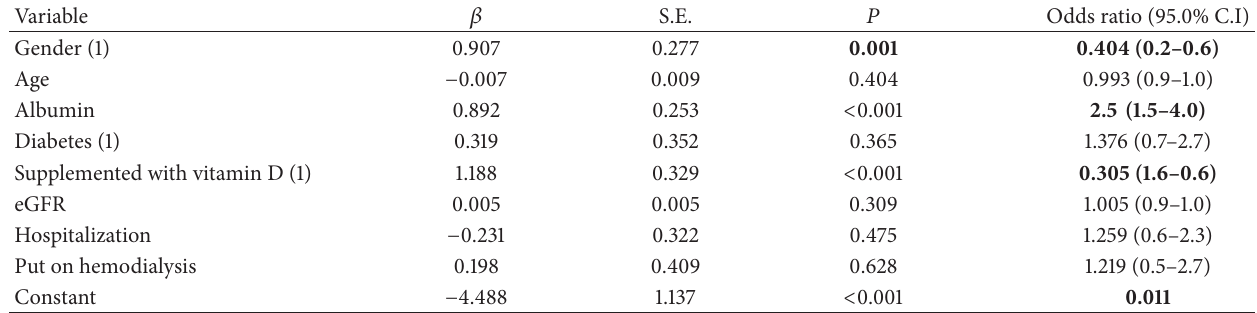
Table 4: Logistic regression models for probability of vitamin D